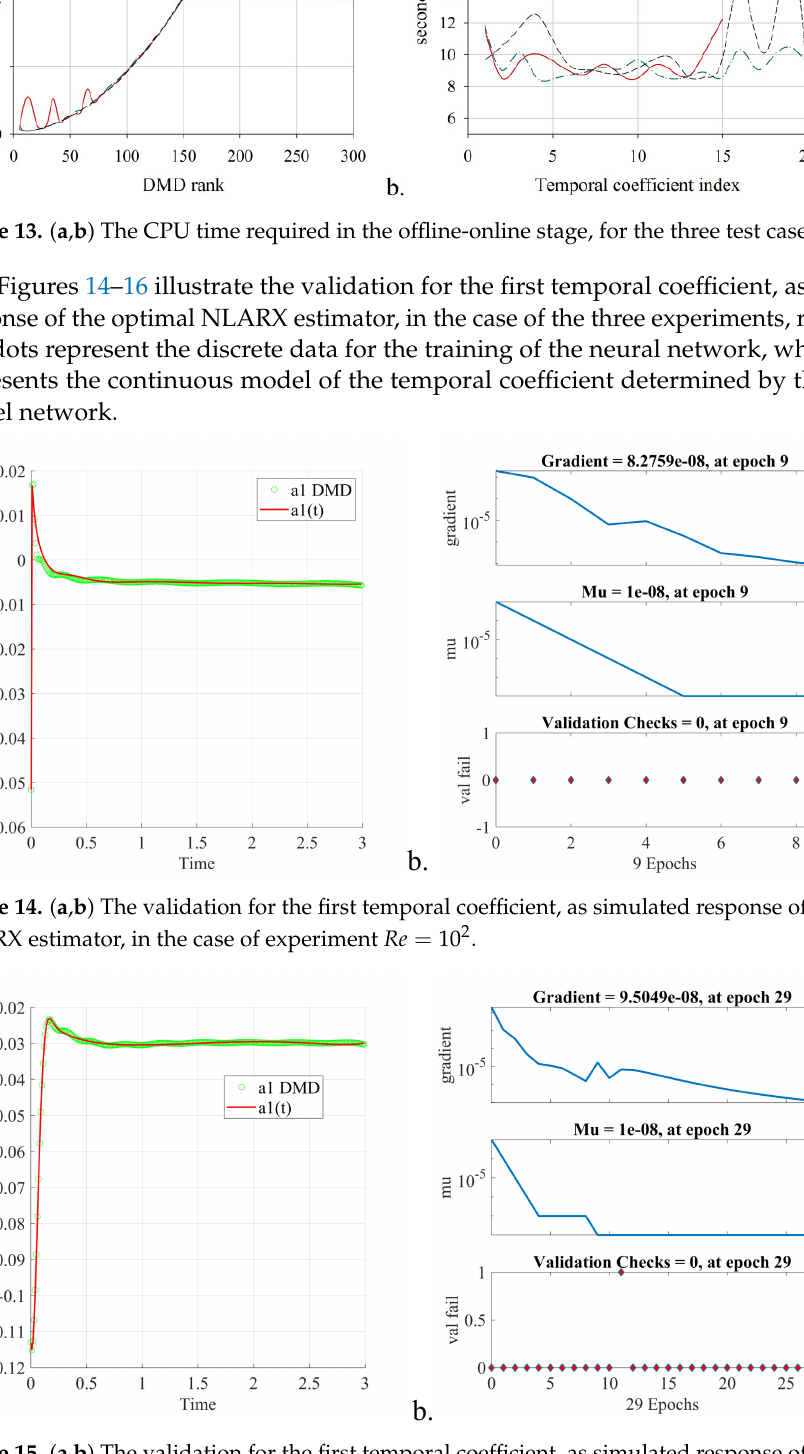
Figure 15. ( a , b ) The validation for the first temporal coefficient, as simulated response of the optimal NLARX estimator, in the case of experiment Re = 10 3